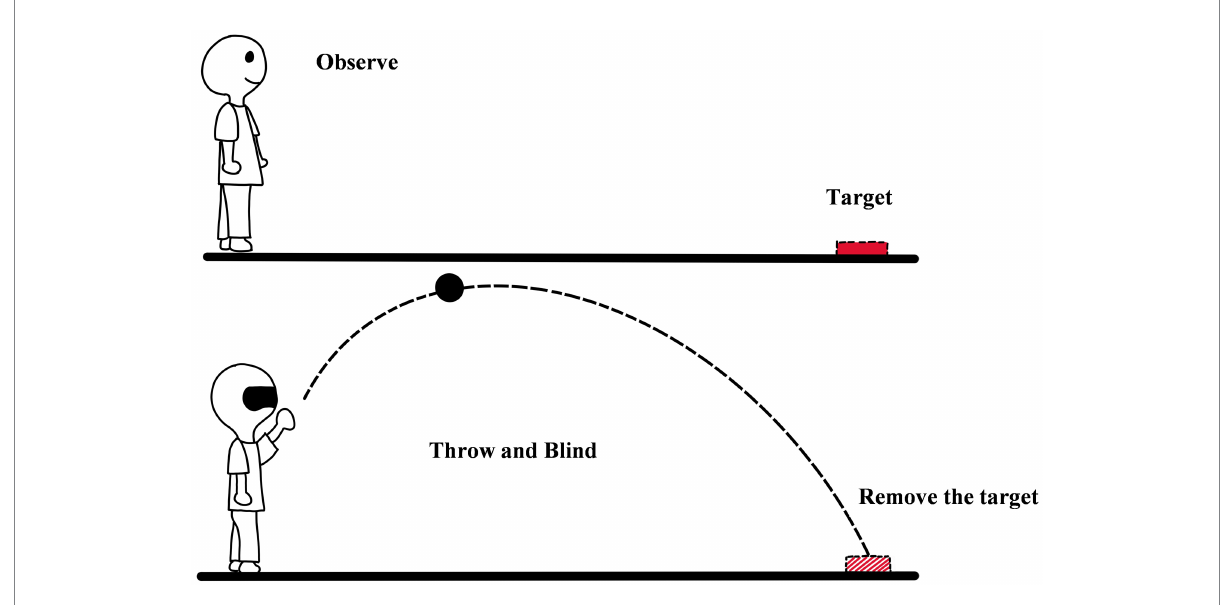
FIGURE 6 The diagram of blindfolded